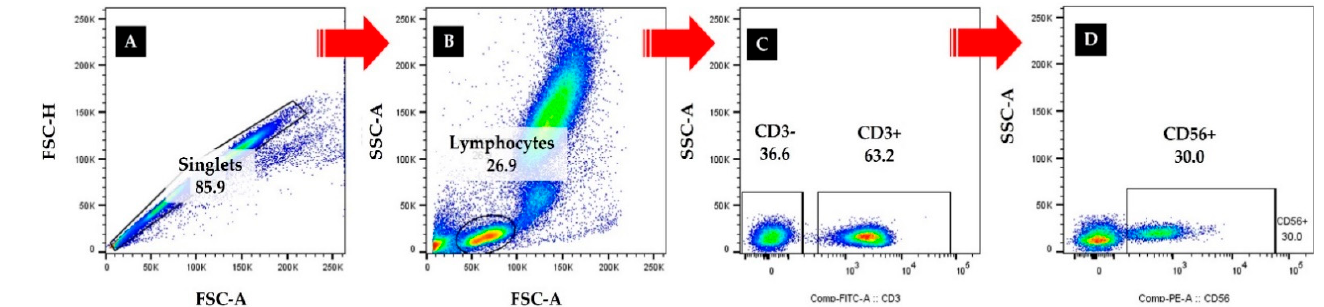
Figure 2. Flow cytometry for analyzing NK cells and T cells in the adolescents.Singlets were gated by area and height of forward scatter. A front-scattered light (FSC)-A and side-scattered light (SSC)-A plot was used to identify nucleated cells. ( A ) Singlets were gated, and doublets were excluded. ( B ) Lymphocyte gate was set based on the size and granularity of the cells. ( C ) CD3 − and CD3+ were defined. ( D ) CD56+ was identified.